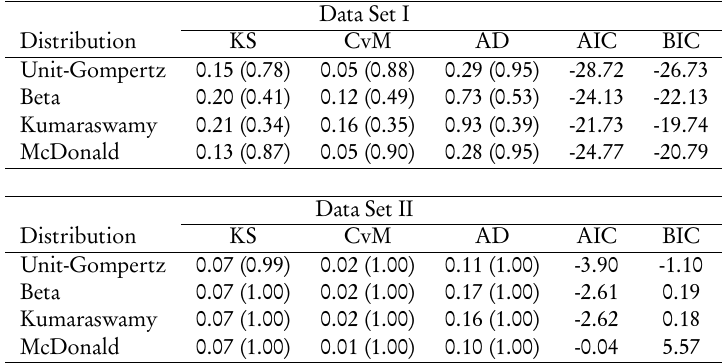
Goodness-of-fit measures ( p -values) and likelihood-based